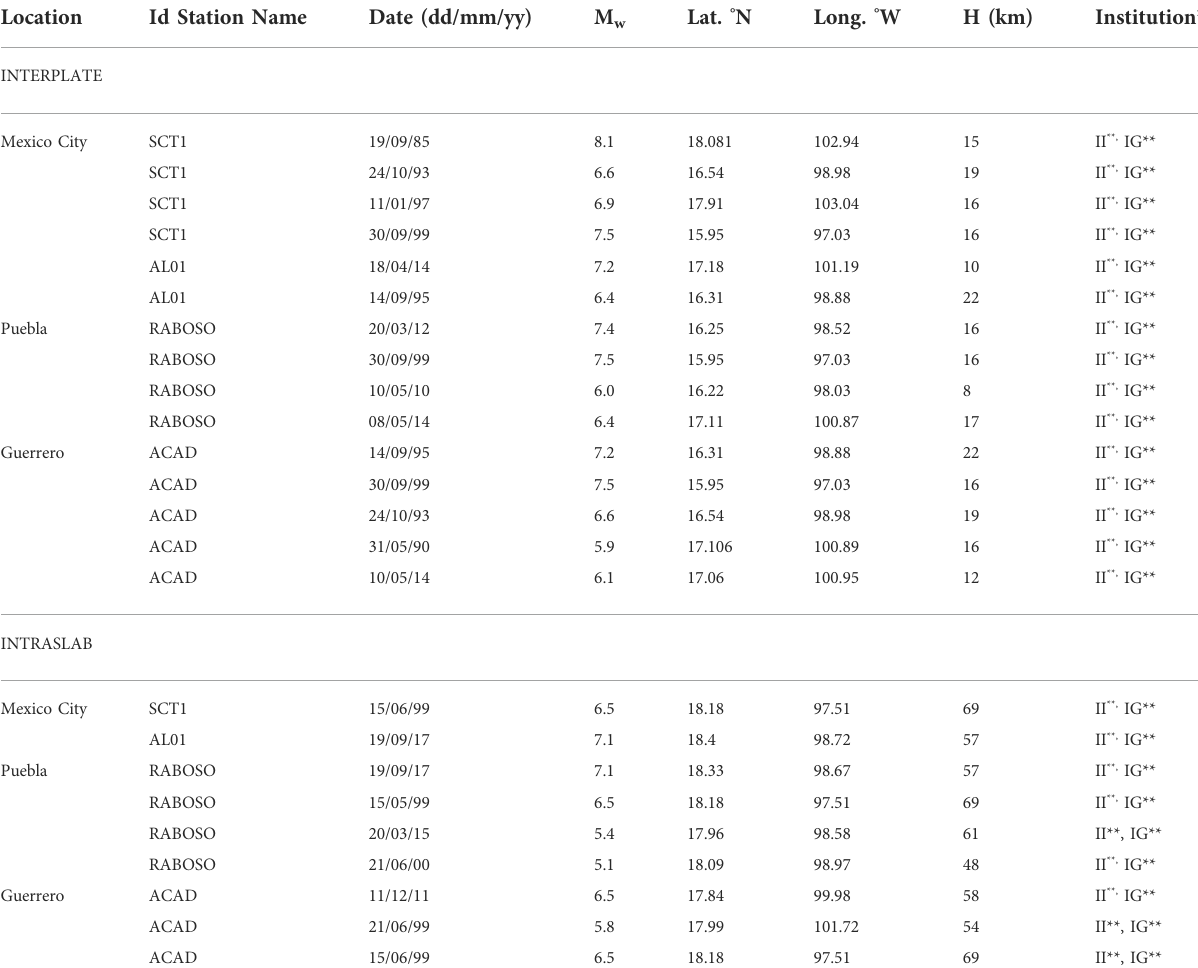
TABLE 1 Interplate and intraslab events and seismic records selected.